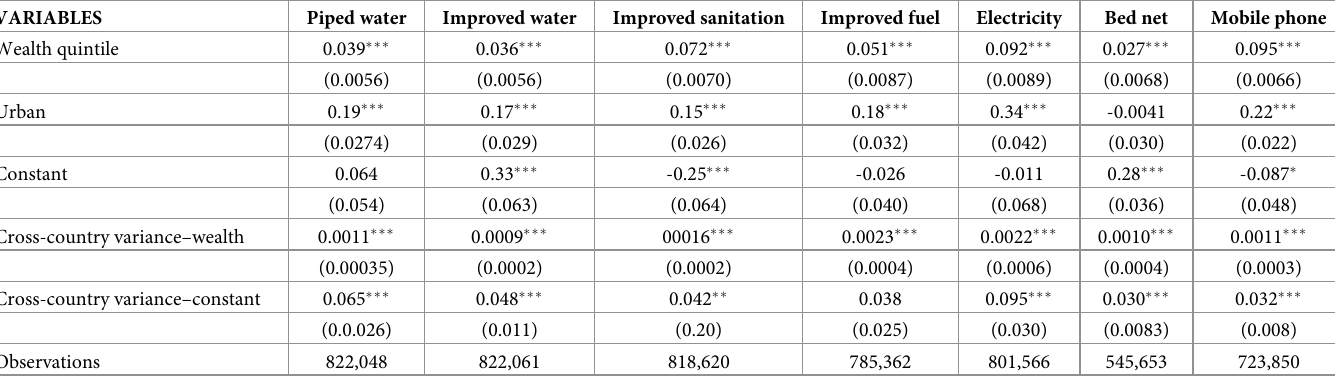
Table 5. Pooled multivariable regression estimates of the association between wealth and EHA access, allowing for country-specific